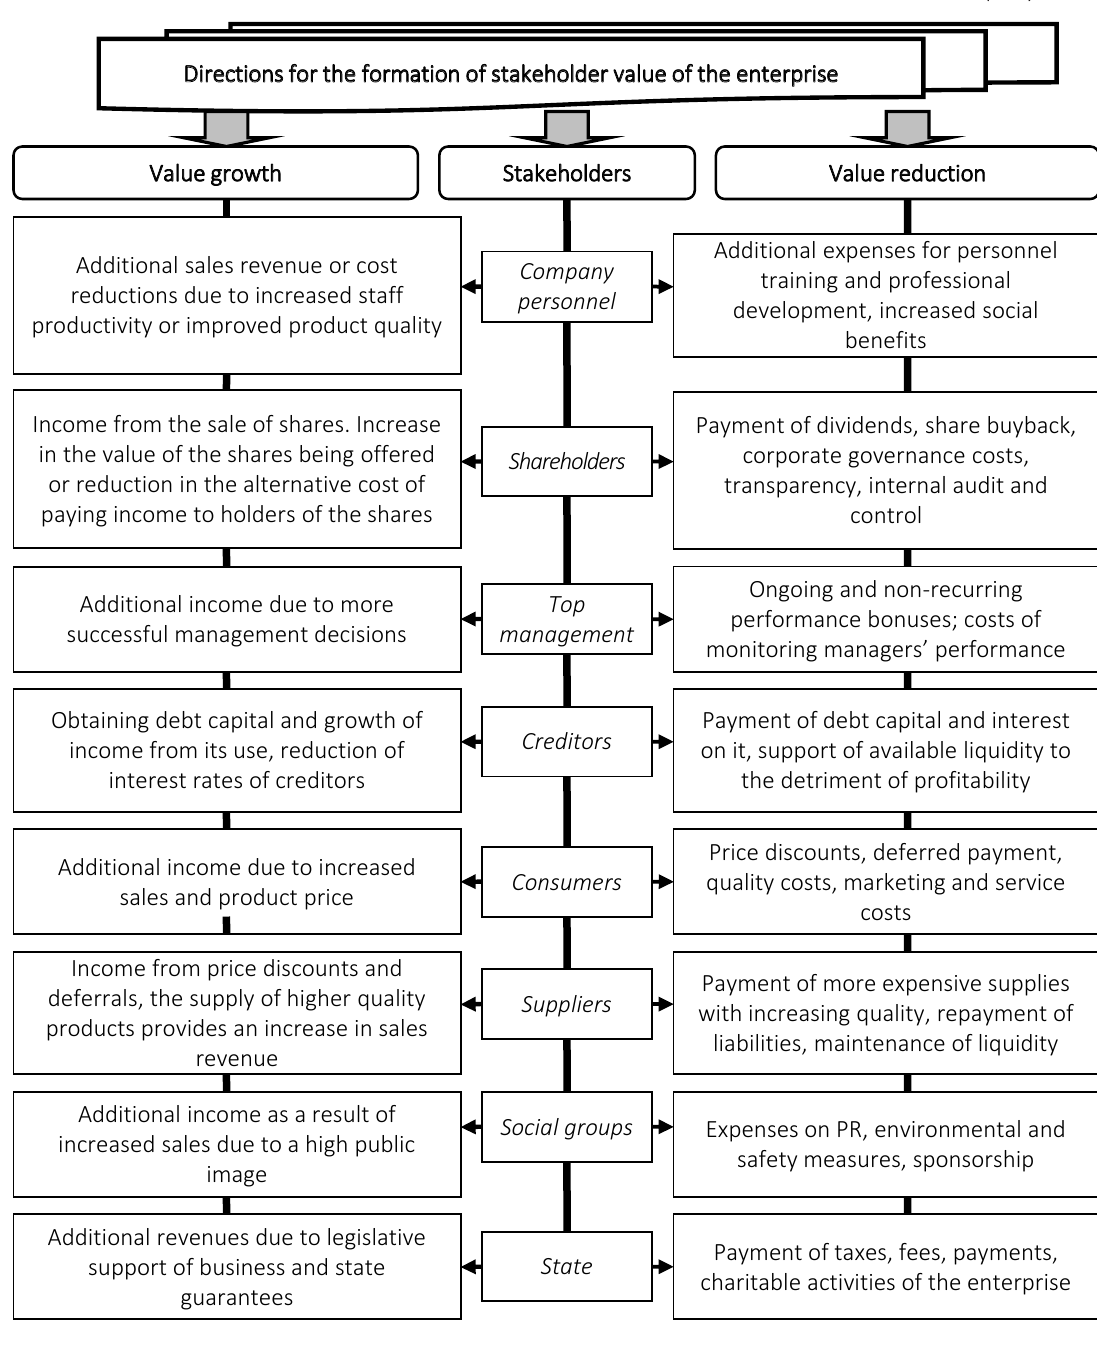
Figure 2. Factors of industrial enterprise value formation in interaction with